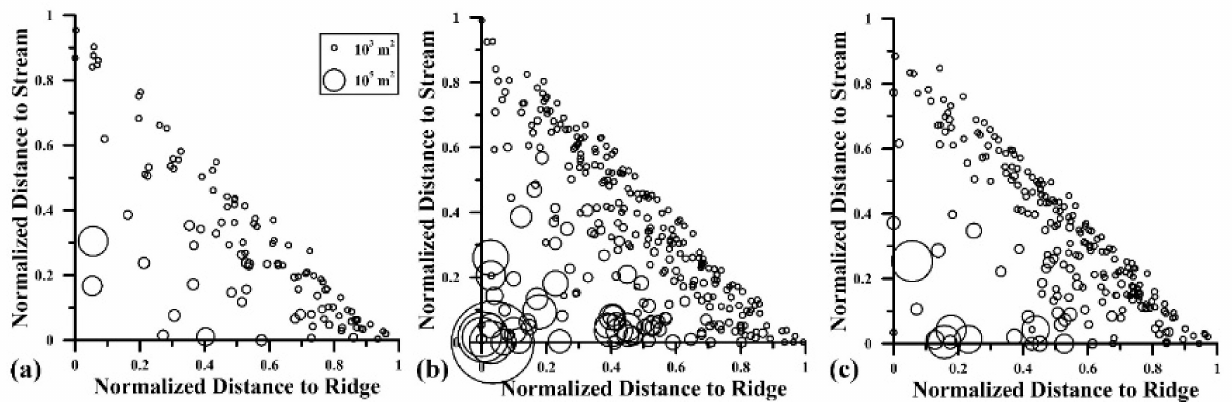
Figure 9. The topographic position analysis of landslide in 2008 ( a ), 2009 ( b ), and 2015 ( c ) in the T01 sub-watershed in the TRW